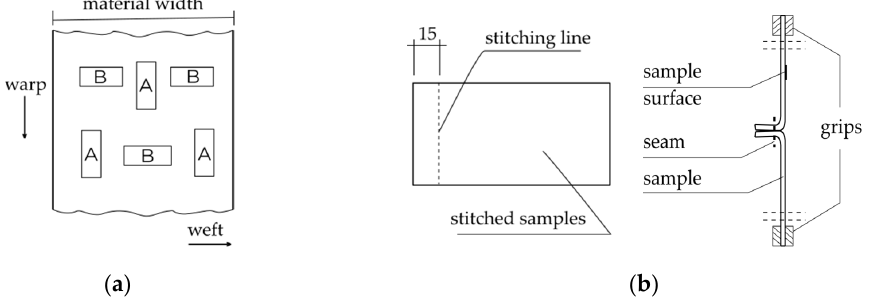
Figure 1. ( a )—fabric cutting method, ( b )—fabric strength test method.